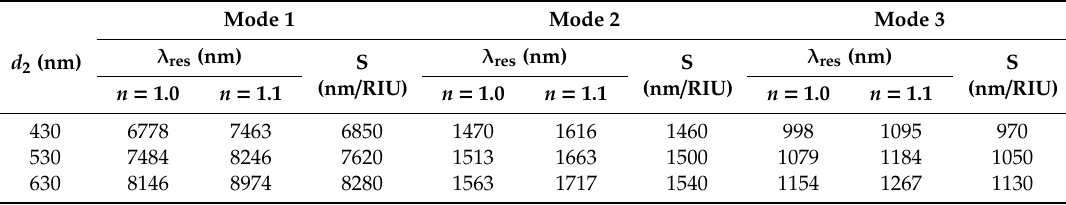
Table 2. Three modes and their corresponding RI sensitivity (S) of the proposed structure with r 1 = 24 nm under testing medium ( n = 1.0 and n = 1.1) versus di ff erent d 2 with 430 nm, 530 nm and 630 nm, respectively.